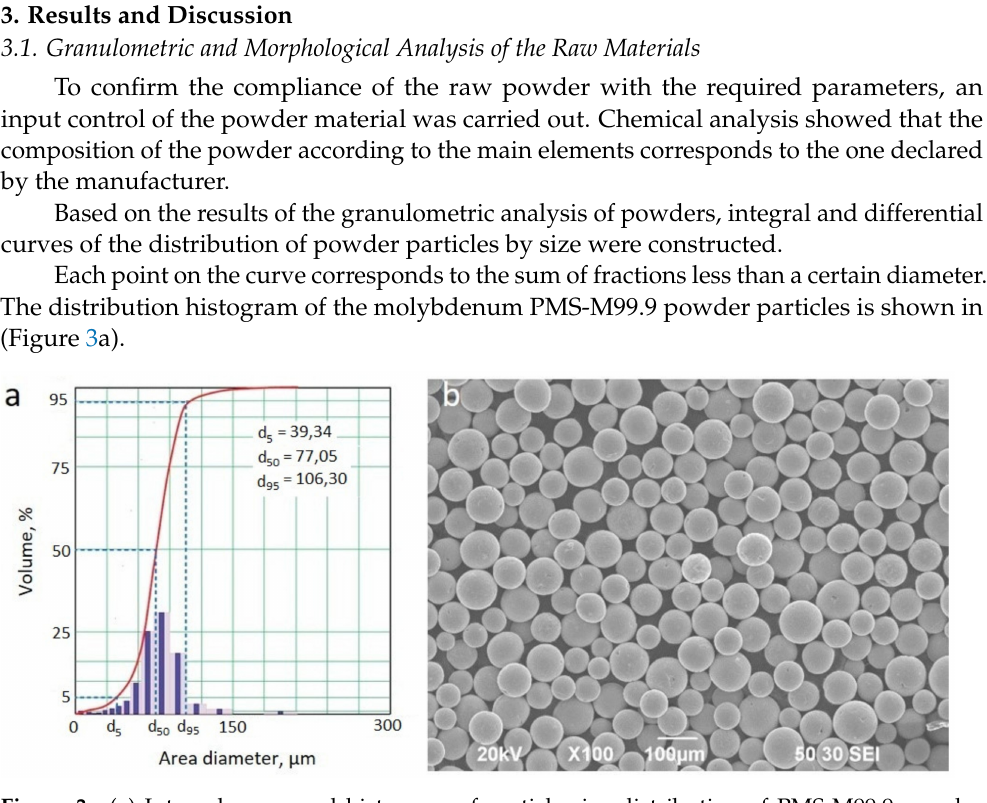
Figure 3. ( a ) Integral curve and histogram of particle size distribution of PMS-M99.9 powder, ( b ) surface morphology of powder particles, ×